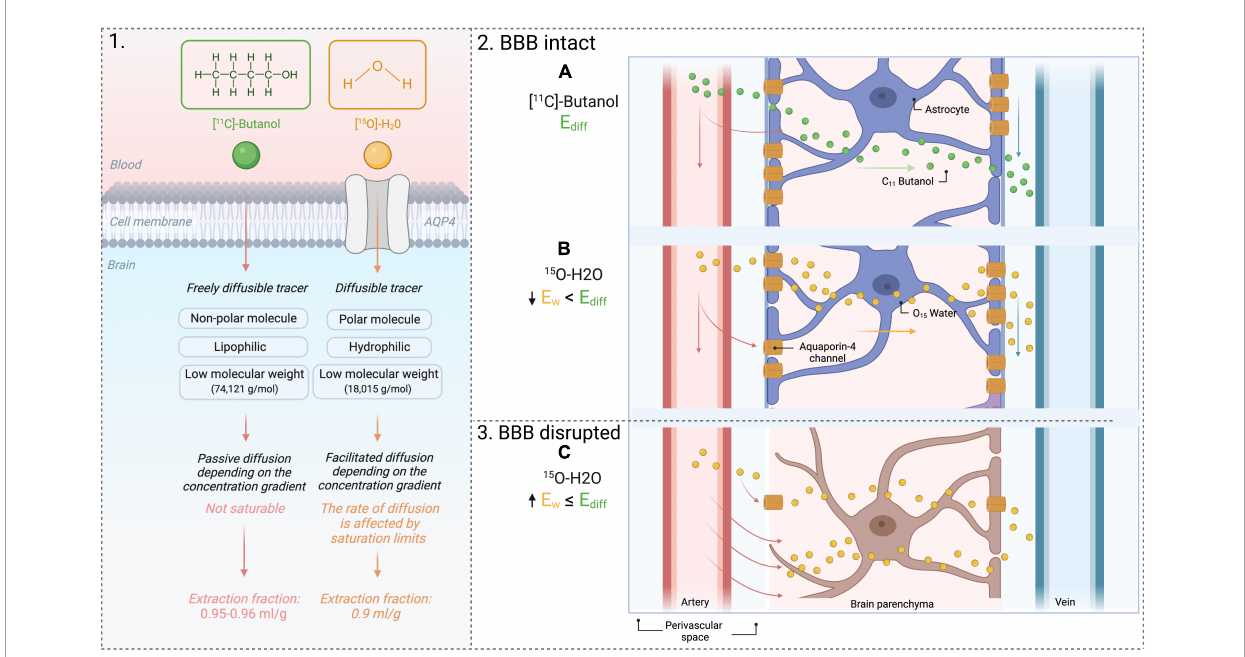
FIGURE5 PET tracers [ 11 C]Butanol and [ 15 O]H 2 O. 1. Difference in extraction fraction of both tracers. 2. Use of 2 tracers to yield an index of BBB permeability. (A) Flow of freely diffusible tracer across an intact BBB. (B) Flow of [ 15 O]H 2 O across an intact BBB. Water transport is modulated by AQP-4 channels. The extraction fraction of water will be lower than that of a freely diffusible tracer, [11C]Butanol. 3. Flow of [ 15 O]H 2 O across a disrupted BBB. (C) The extraction fraction of water will increase because of water extravasation into the brain through the BBB. AQP4, aquaporin-4; E w , extraction fraction of water; E diff , extraction fraction of diffusible